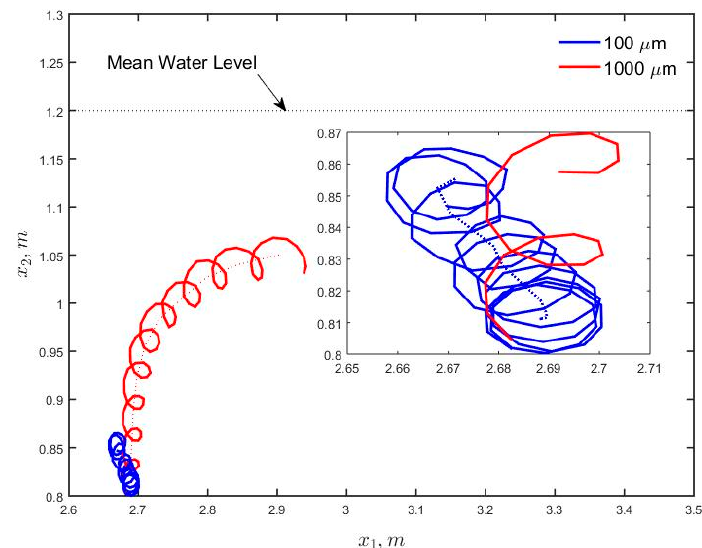
Figure 8. Ensemble averaged plume trajectory (over 500 particles of each size) of particles of diameter 100 and 1000 μ m. The particles were released at ]3,5.2[ 1 through the plume trajectory was obtained by window averaging over each trajectory loop corresponding to the wave period.